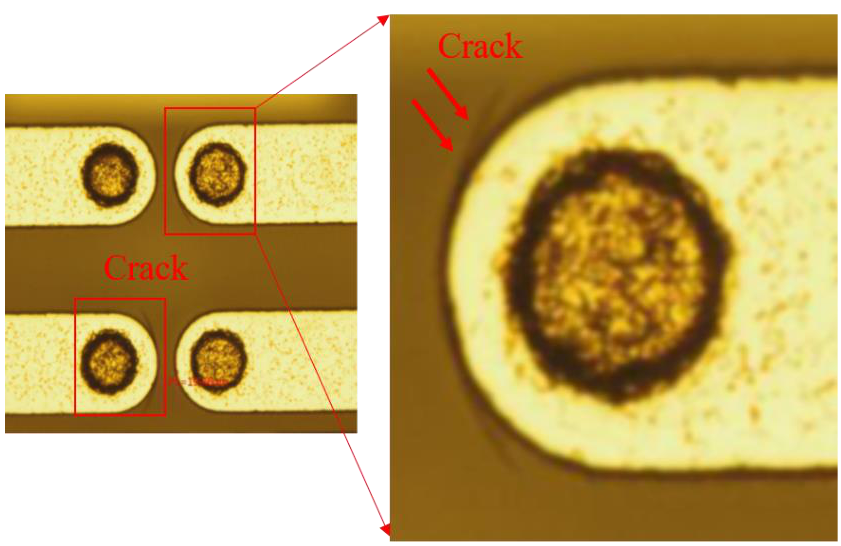
Figure 3. The failure mode of thermo-mechanically induced vertical cracks are observed.